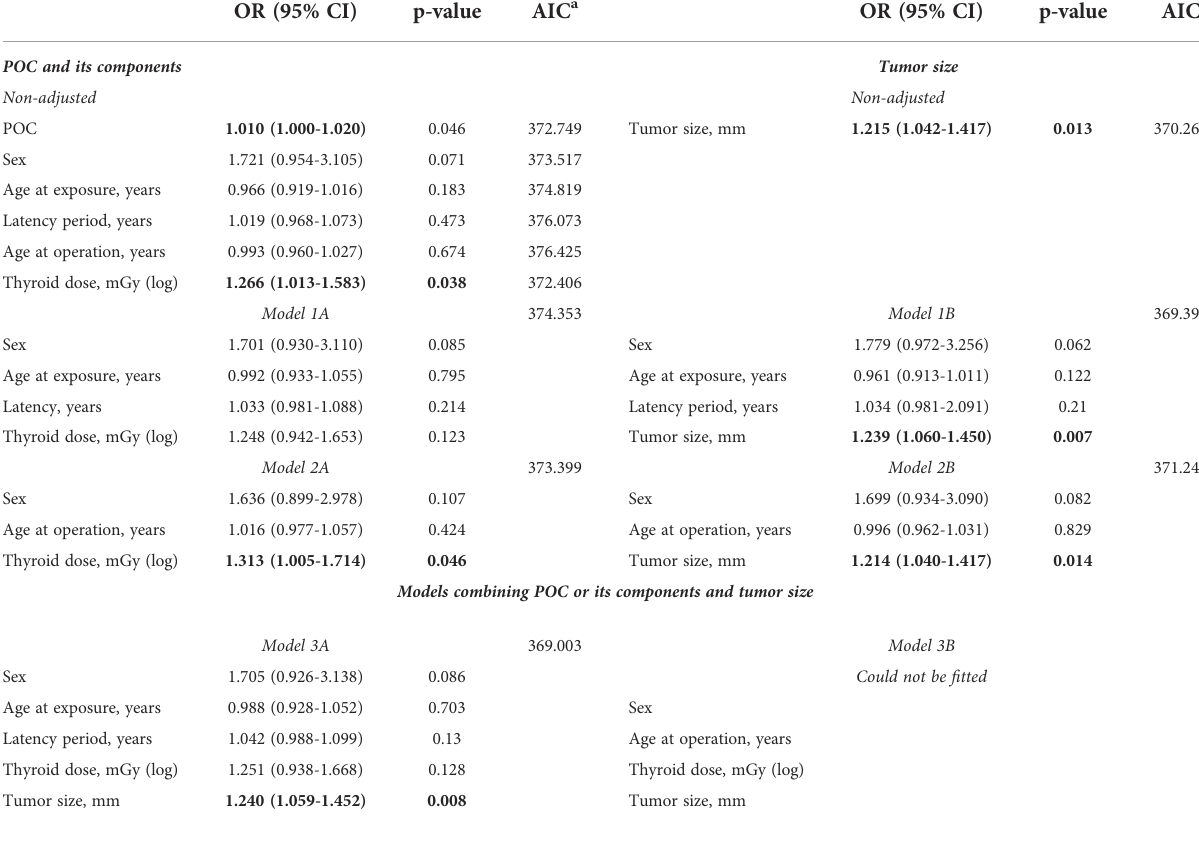
TABLE 3 Effects of thyroid dose and tumor size on extrathyroidal